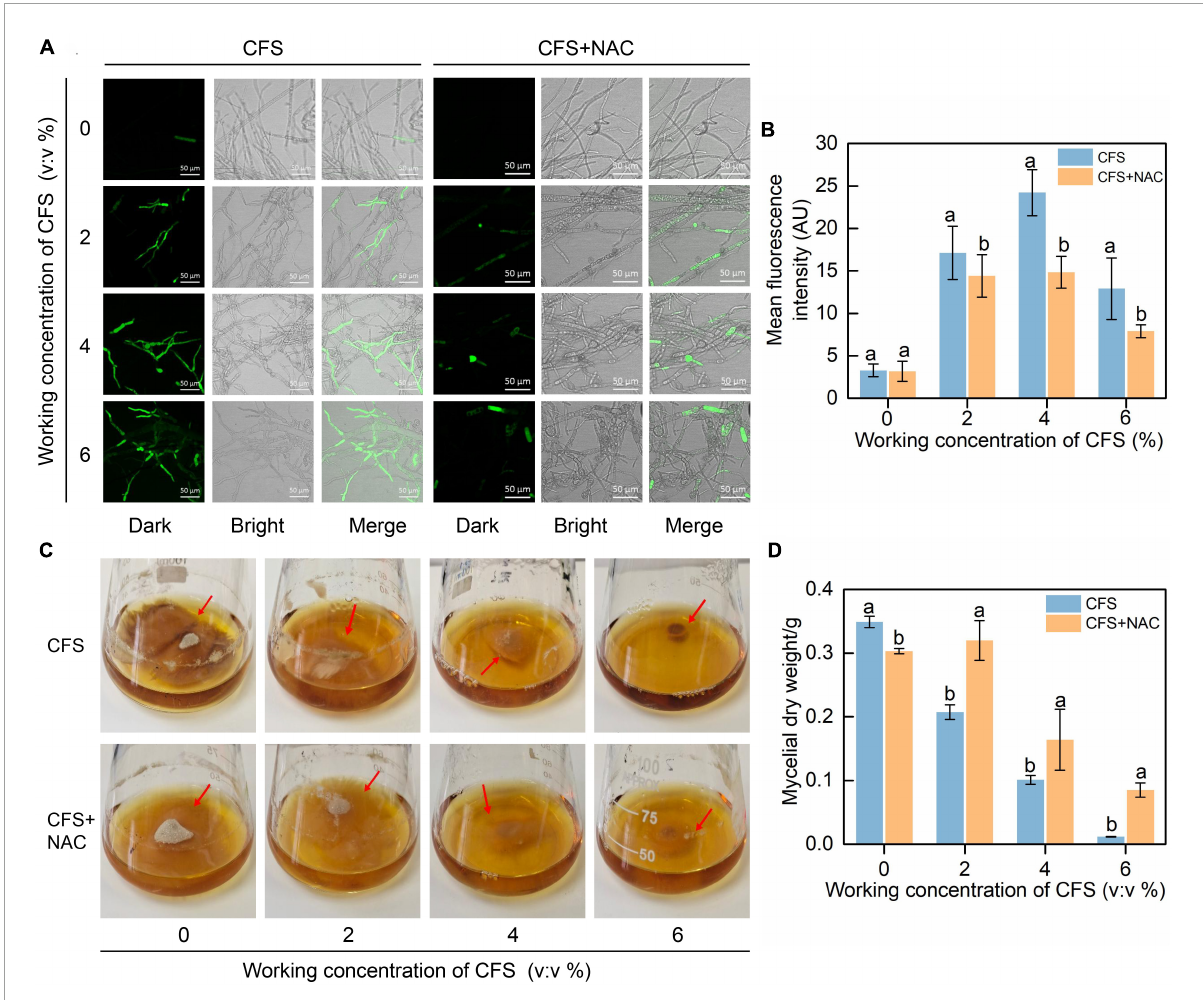
FIGURE8 Effect of N-Acetylcysteine (NAC) on the reactive oxygen species (ROS) accumulation and the growth of mycelia treated with cell-free supernatant (CFS). The culture was amended with different concentrations of CFS with or without 10 mM NAC. (A) The images were recorded using confocal laser microscopy at 488 nm excitation and 520 nm emission. (B) The relative intensity of fluorescence of each treatment was measured by ImageJ. (C) Images were recorded after 3 days of incubation. (D) Statistical analysis for mycelial dry weight. Error bars indicate standard errors of the means of two repeated experiments. Different letters above the bars indicate significant differences within each group according to Duncan’s multiple range test ( p <